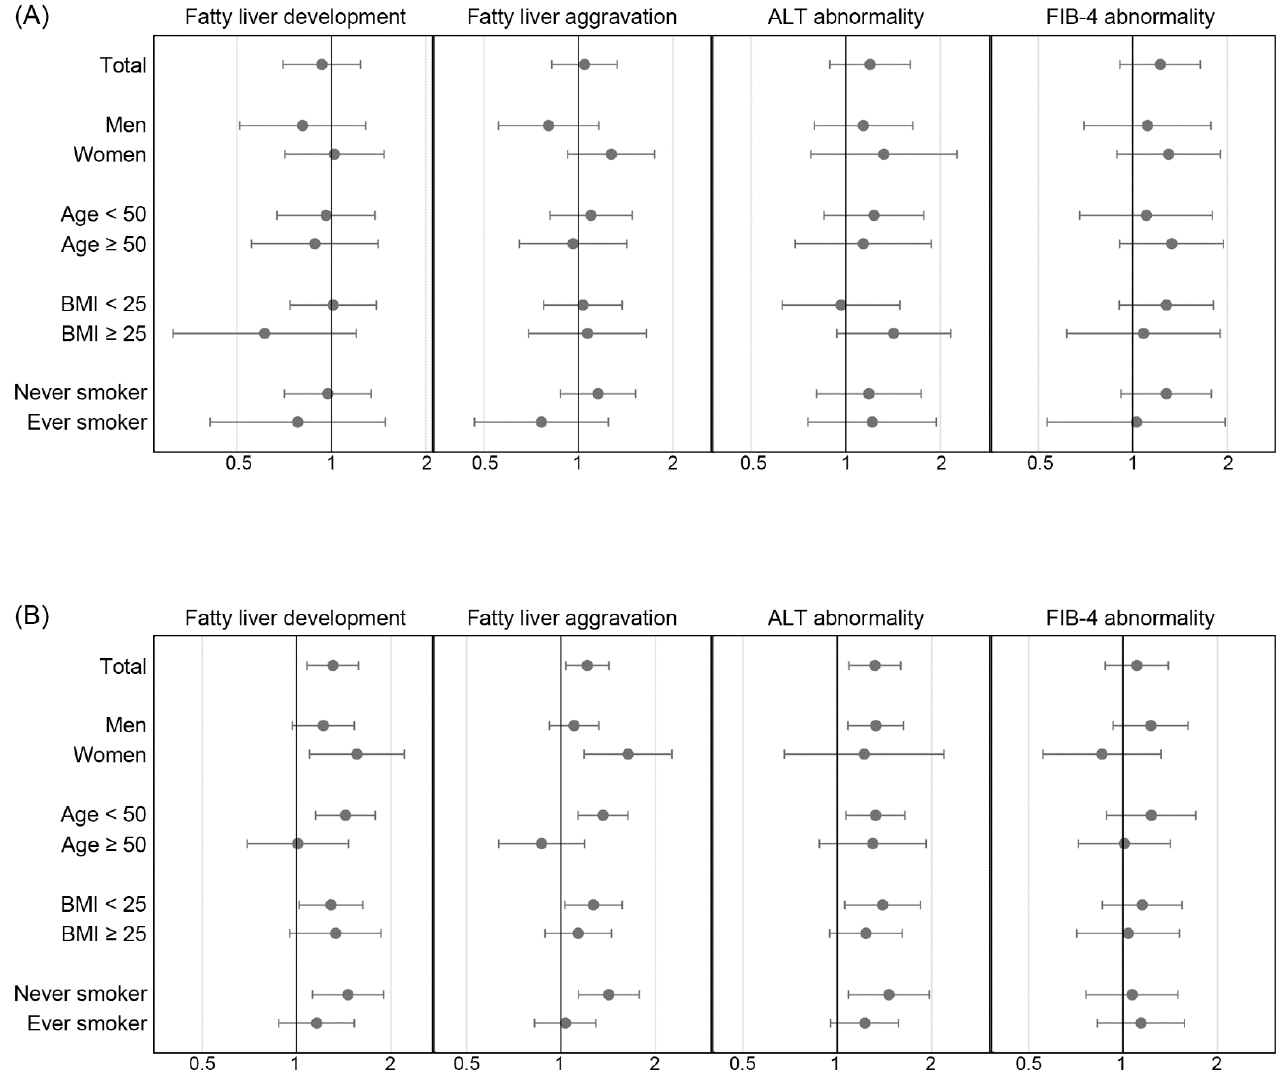
Figure 4. The SSD transition odds ratios compared to the pre-SSD change in ( A ) the non-drinker and ( B ) alcohol consumption groups. Subgroup analyses were conducted according to sex, age, obesity, and smoking history. Dots and error bars show odds ratios and 95%CI.